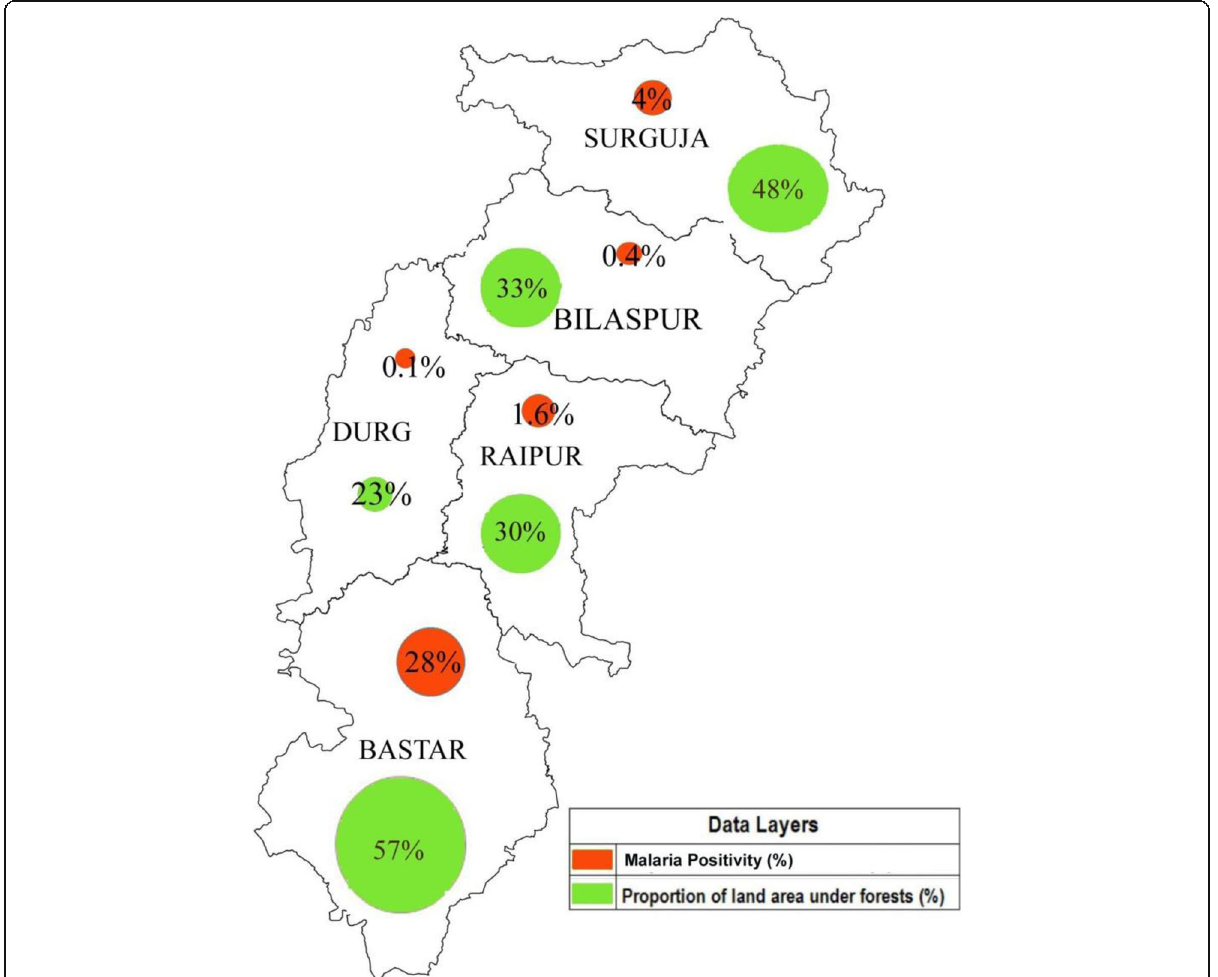
Fig. 2 Map of Chhattisgarh showing different administrative divisions and key indicators. Sources of data: forest cover [33] and malaria positivity